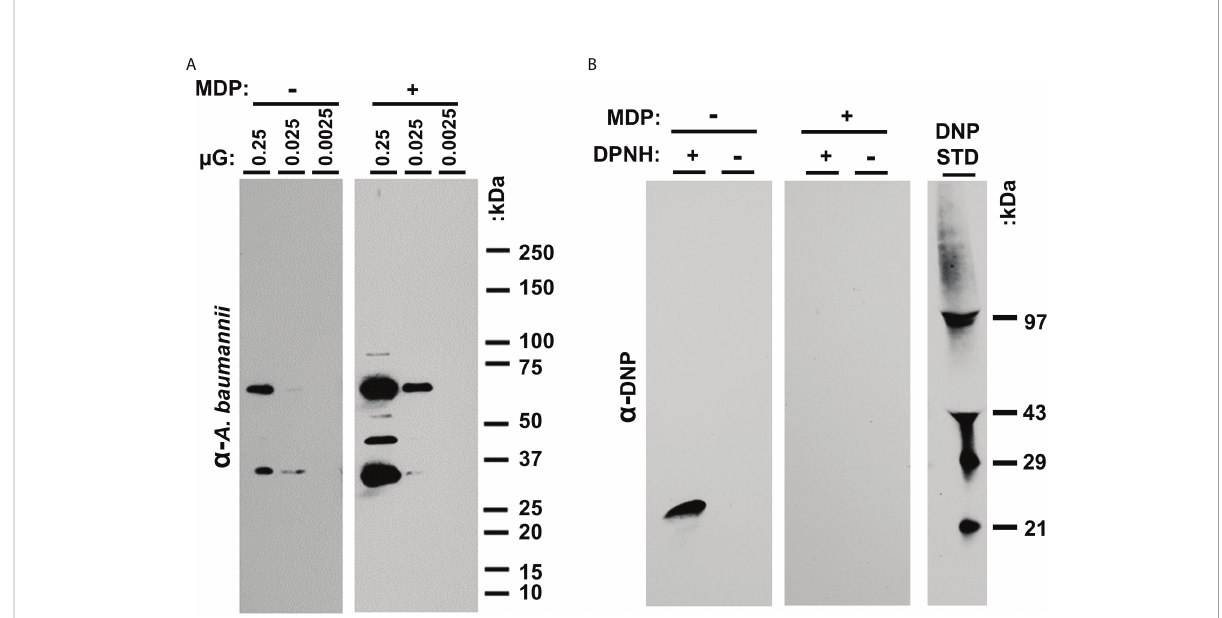
FIGURE 3 (A) Analysis of UVC-irradiated immunogens with and without MDP. Western analysis of epitopes. P1 samples irradiated in the presence and absence of MDP were loaded at the indicated concentration (approx. 2.5 x 10 7 CFU in lane 1) in replicate. (B) Carbonylation analysis. B1 and P1 samples were UVC inactivated with and without the inclusion of the MDP Mn-antioxidant complex. After reacting the proteins with DNPH, the samples were denatured, electrophoresed, and transferred to nitrocellulose. The membranes were probed with anti-DNP antibody and detected with HRP-conjugated secondary